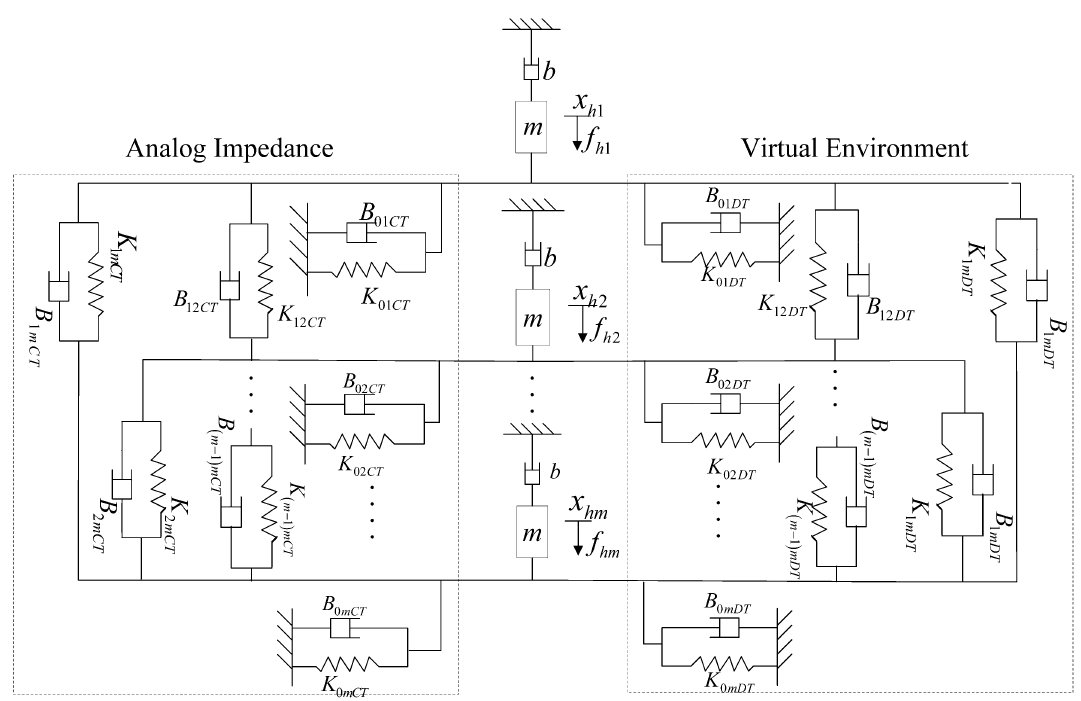
Figure 4. A multiple-user haptic virtual surgery simulation system with the analogue